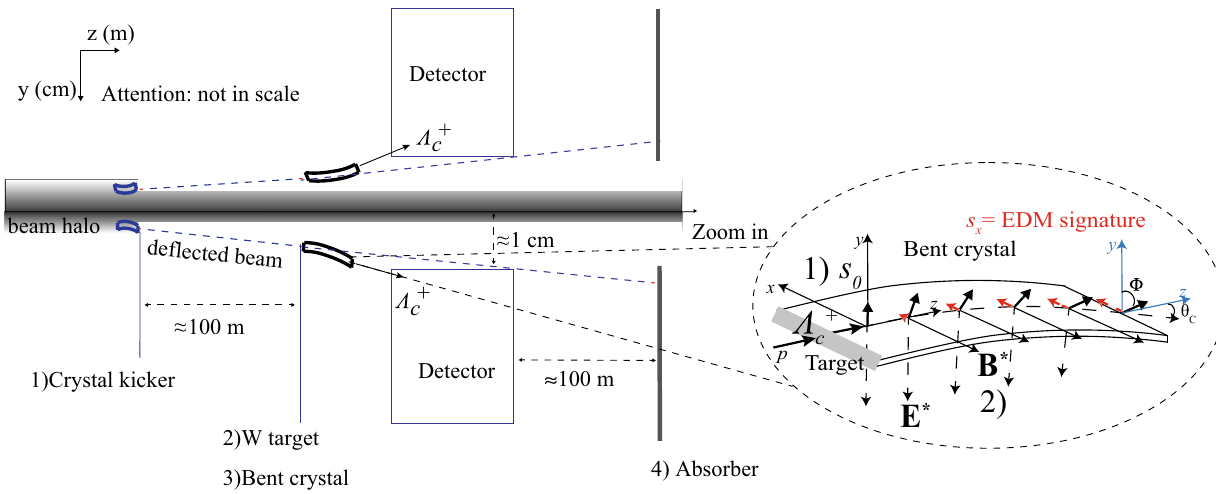
Fig. 7 Conceptual layout of the fixed-target setup shown in side view with down- and up-bending crystals. The zoom in shows the spin precession in the down-bending crystal for channeled Λ + c